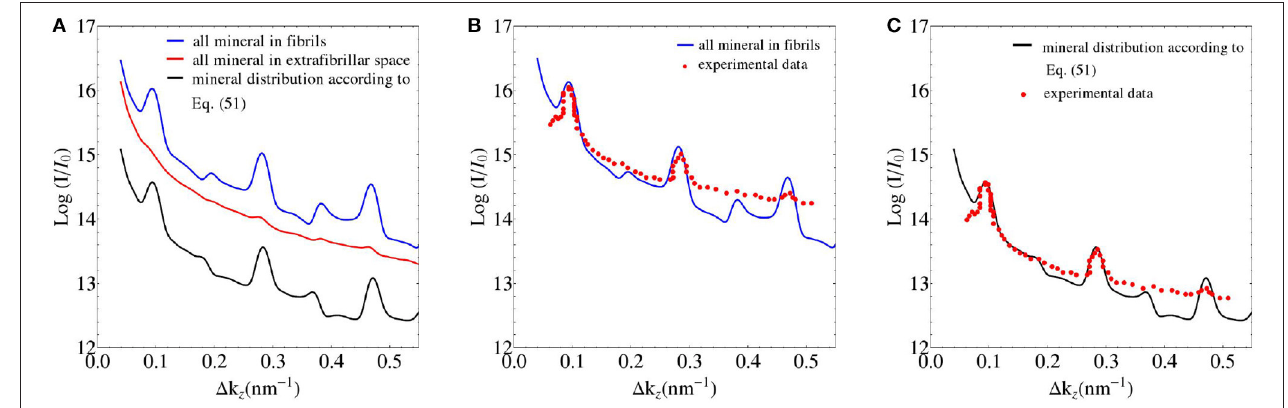
FIGURE 7 | (A) SAXS pattern predictions based on different mineral distribution schemes in bone ultrastructure; and (B,C) comparison to experimental data of Chen et al. [58].